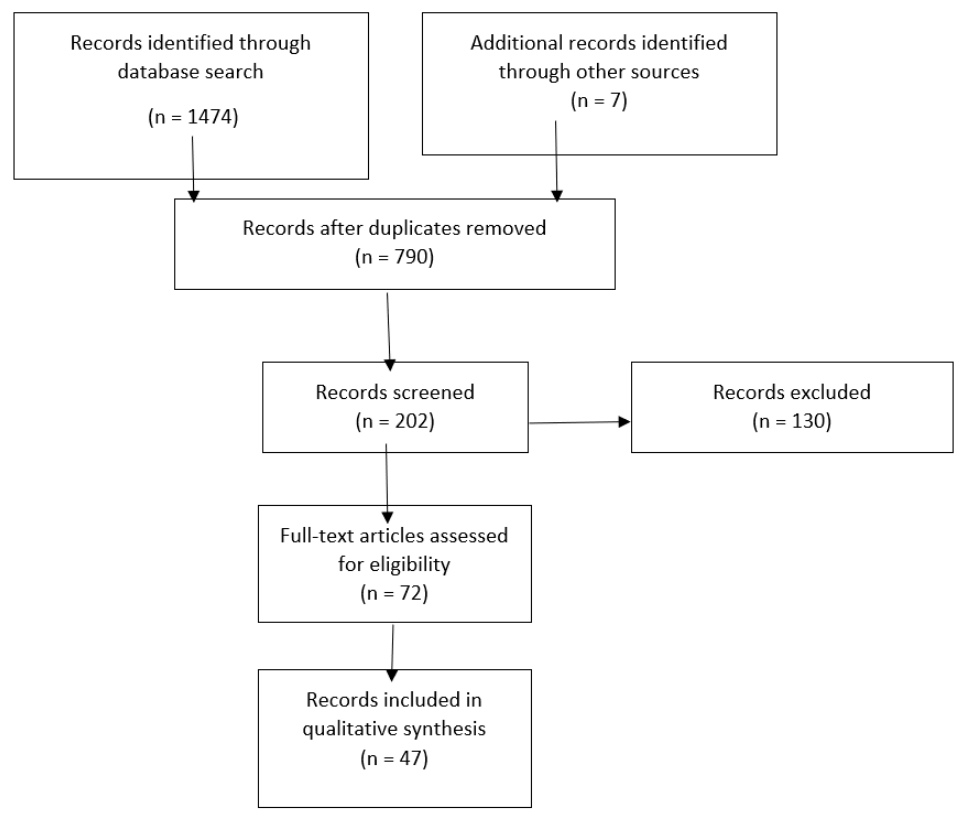
Figure 1. PRISMA flow diagram.